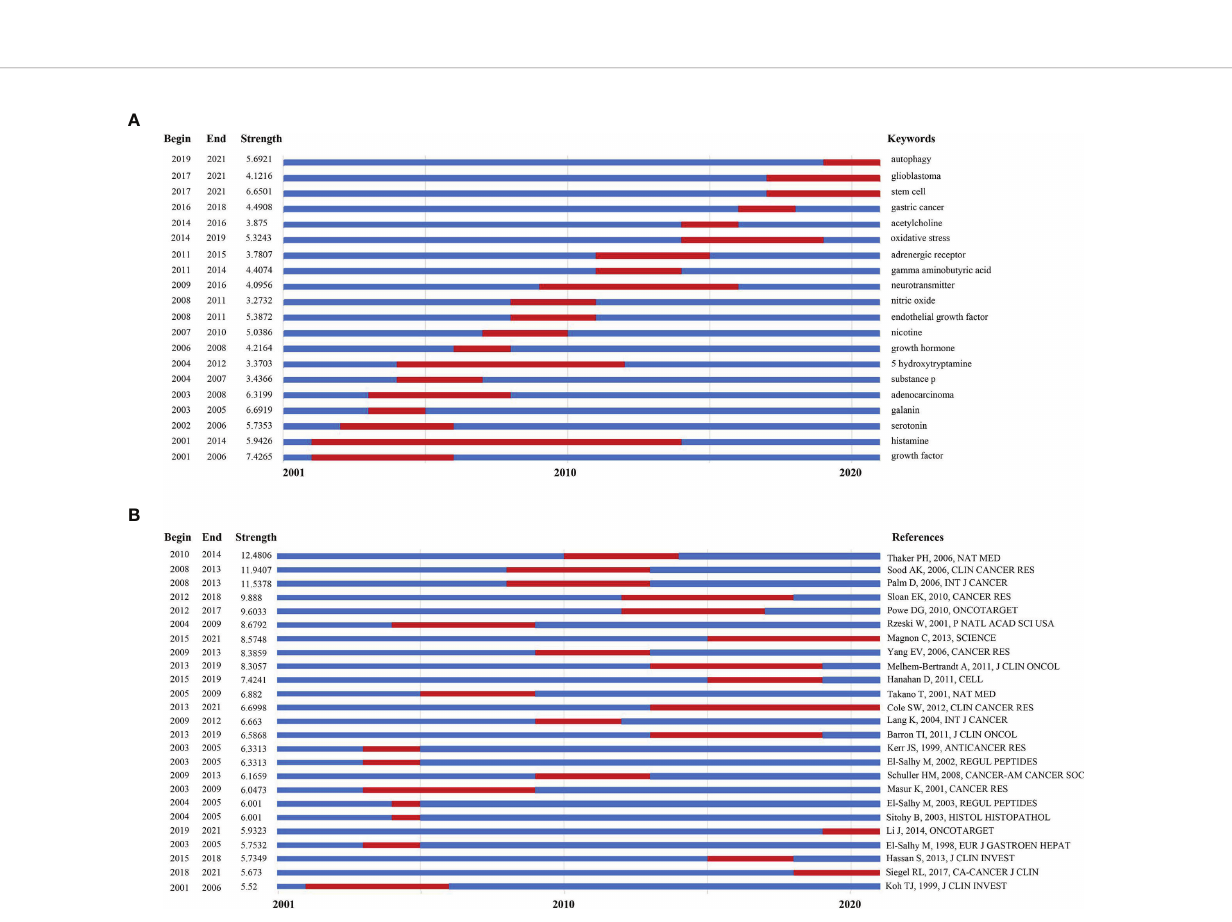
FIGURE 5 | (A) Keywords with the strongest burst strength of the 1285 citing articles on neurotransmitters and tumor progression research between 2001 and 2021. Keywords marked in red indicates a sudden increase in the usage frequency of this keyword during that period. Blue represents a relatively unpopular time period; (B) References with the strongest burst strength of the 39677 references on neurotransmitters and tumor progression research between 2001 and 2021. References marked in red indicates a sudden increase in cited frequency of this article during that period. Blue represents a relatively unpopular time